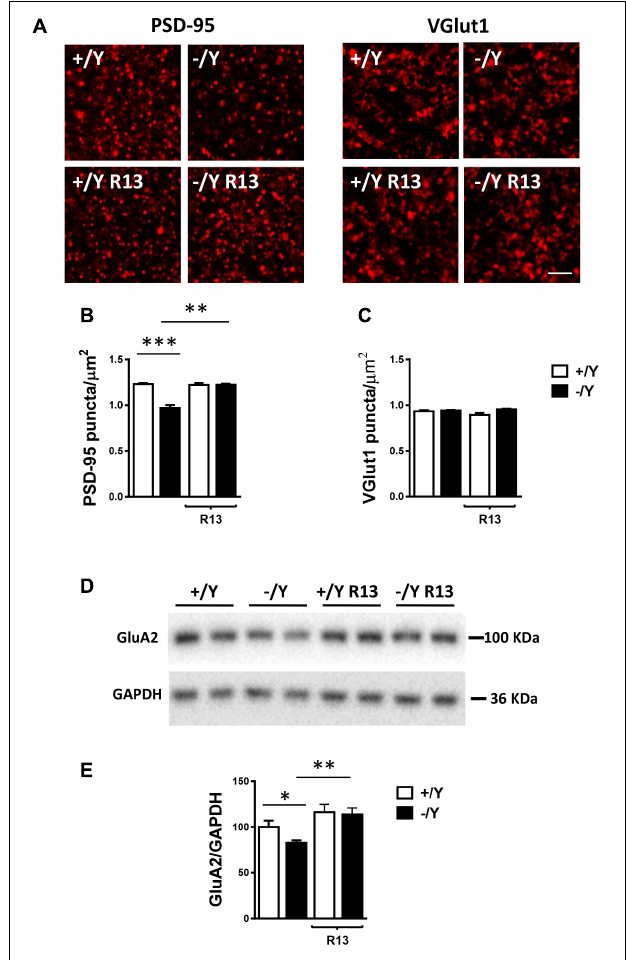
FIGURE 8 | Effect of treatment with R13 on neuronal connectivity in the perirhinal cortex of Cdkl5 − /Y mice. (A) Representative fluorescence image of a PRC section processed for PSD-95 or VGlut1 immunoreactivity, showing examples of PSD-95 and VGlut1 immunoreactive puncta. Scale bar: 3 µ m. (B,C) Number of fluorescent puncta per µ m 2 exhibiting PSD-95 (B) or VGlut1 (C) immunoreactivity in layers II-III of the PRC of vehicle-treated P50 Cdkl5 +/Y ( n = 4) and Cdkl5 − /Y ( n = 4) mice, and P50 Cdkl5 +/Y ( n = 4) and Cdkl5 − /Y ( n = 4) mice treated with R13. (D,E) Western blot analysis of GluA2-AMPA levels in PRC homogenates of vehicle-treated P50 Cdkl5 +/Y ( n = 6) and Cdkl5 − /Y ( n = 6) mice and R13-treated P50 Cdkl5 − /Y ( n = 5) mice. Values represent mean ± SE. ∗ p < 0.05; ∗∗ p < 0.01; ∗∗∗ p < 0.001 (data in (B,C) Fisher’s LSD test after two-way ANOVA; data in (E) Student’s two-tailed t